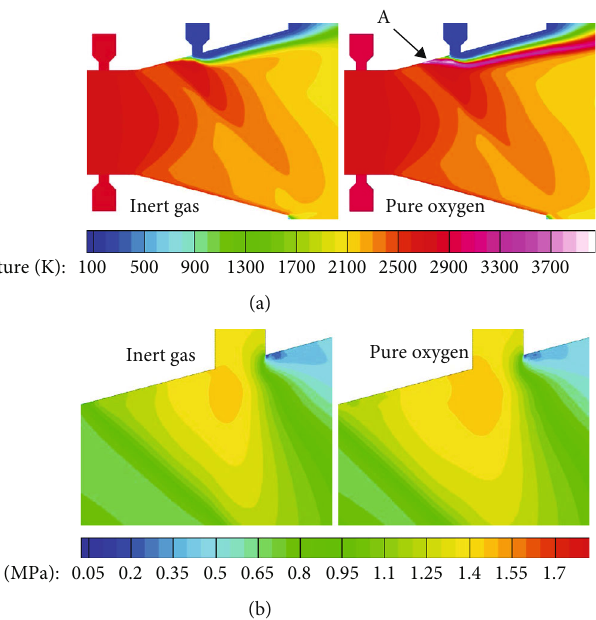
Figure 15: Contour of fl ow fi eld injected in divergence section. (a) temperature Contours. (b) Contours of pressure for local region.